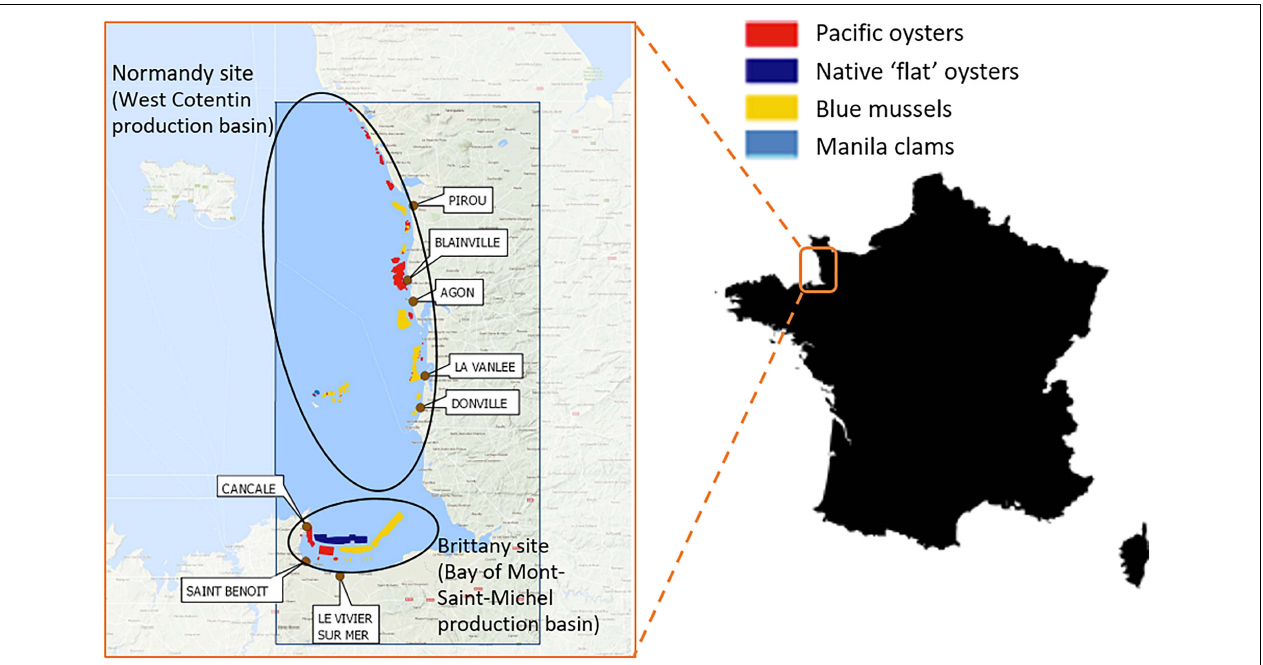
FIGURE 1 | Official layout of shellfish growing areas (cadastre) of the studied territory. Data source: DDTM35 (2014) and DDTM50 (2017).